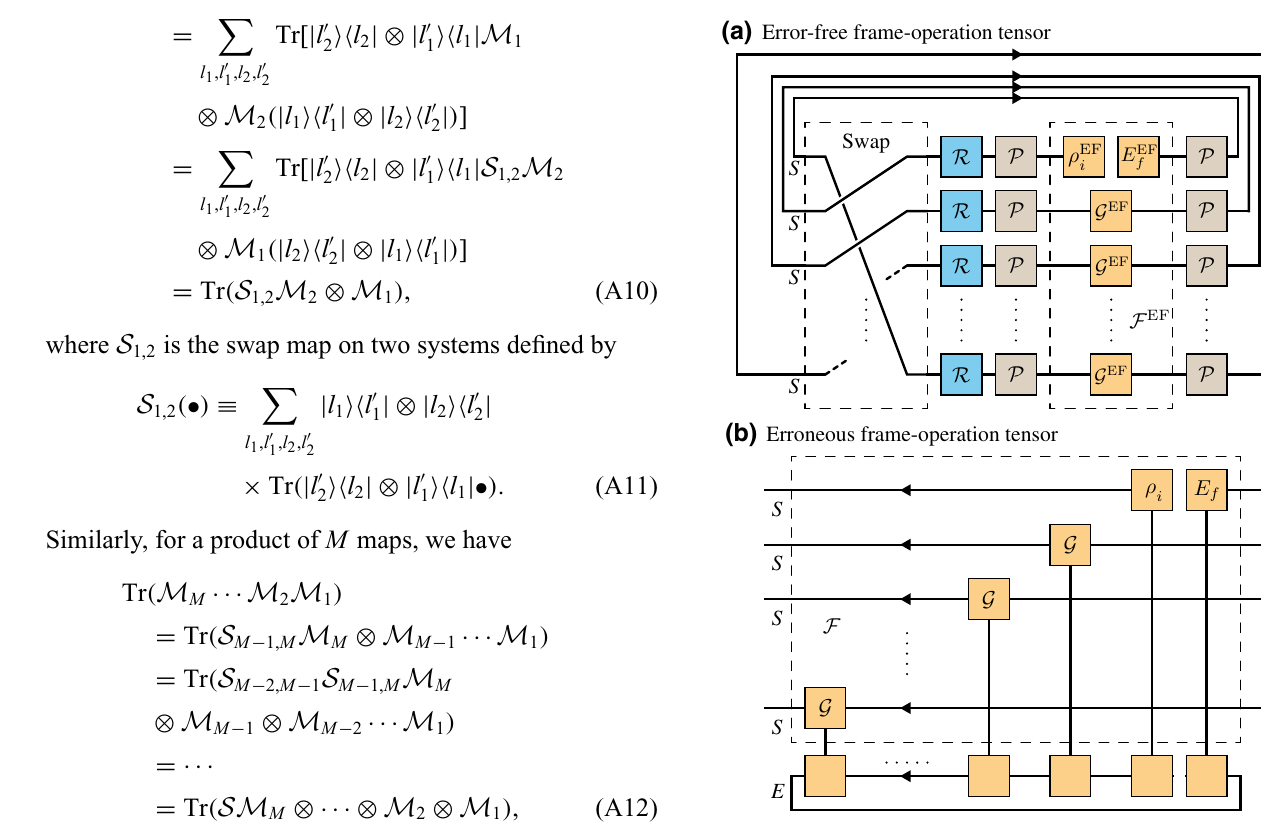
FIG. 14. The error-free frame-operation tensor F EF and the erroneous frame-operation tensor F . The arrows denote the direction of the time. Along the direction of arrows, R = R 1 , R 2 , . . . , R N + 1 , P = P 1 , P 2 , . . . , P 2 N + 2 , G EF = G EF , G EF , . . . , G EF , and G = G 1 , G 2 , . . . , G N . Here S N 1 2 denotes system and E denotes